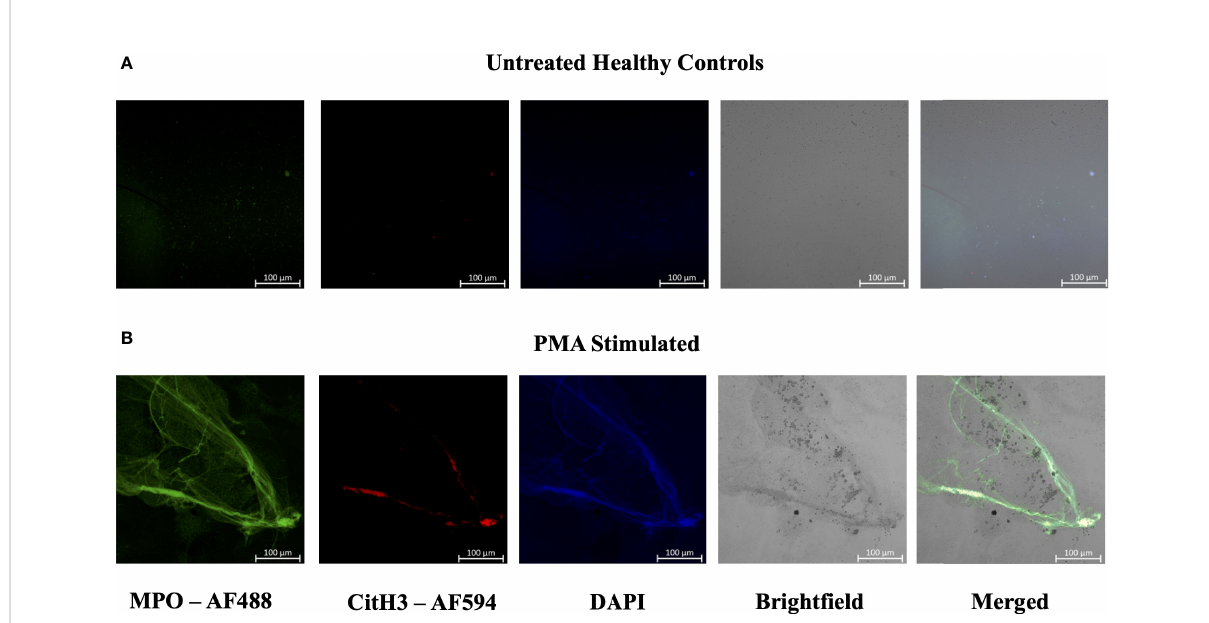
FIGURE 5 Plasma smear circulating NETs can be detected through bright fi eld microscopy. Plasma smeared poly-l-lysine slides were prepared and stained with MPO antibody (green, AF488), CitH3 (red, AF594) and DAPI (blue) and single channel images were obtained for (A) unstimulated healthy control and (B) PMA stimulated samples. NETs were identi fi ed and bright fi eld images overlapped with speci fi c antibody markers in (B) PMA stimulated sample, therefore con fi rming the presence of circulating NETs. Individual merged images represent separate donors (n=2). All images were taken on ZEISS Confocal M880 at 20x objective. Set scale